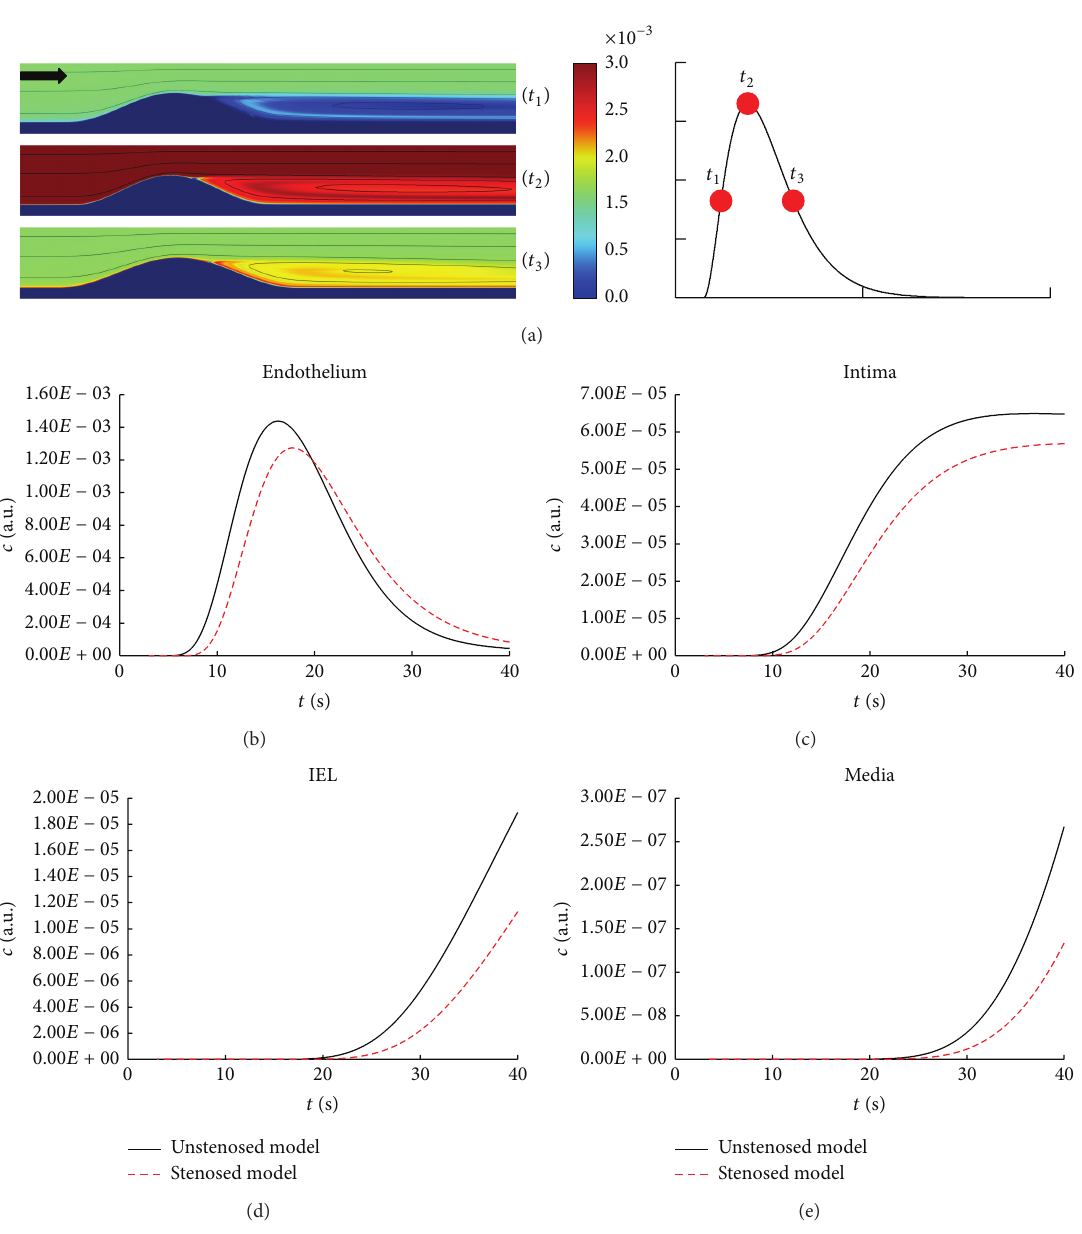
Figure 6: Effects of disturbed flow on contrast agent transport. (a) Concentration distribution in the stenosed region at three time points of the contrast injection at the inlet. 𝑡 1 is the moment with half maximal concentration in the increasing phase; 𝑡 2 is the moment with maximal concentration; 𝑡 3 is the moment with half maximal concentration in the decreasing phase. (b–e) Comparison of the concentration-time curve across the arterial wall between the unstenosed model and the stenosed one at the axial direction of 10𝐷